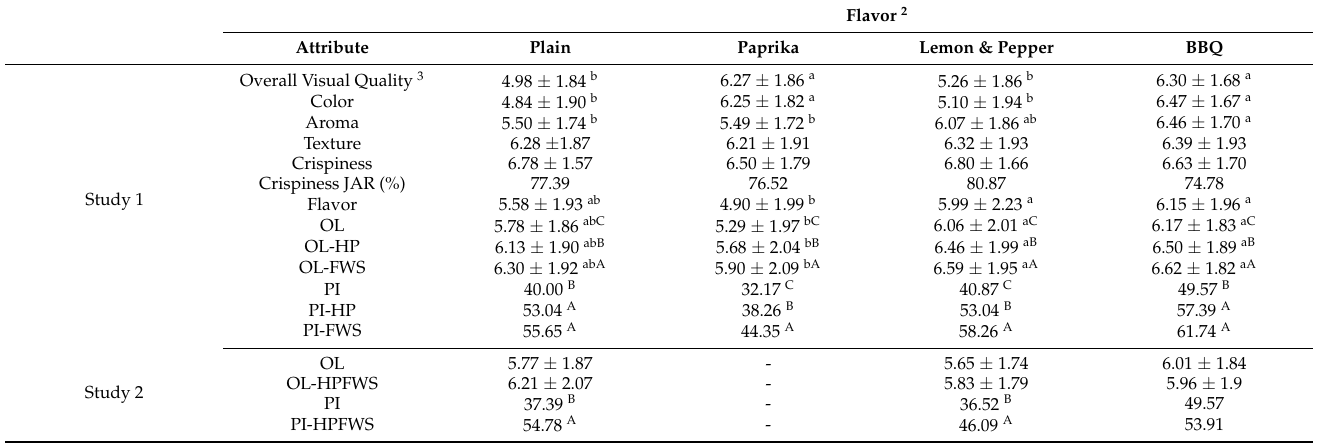
Table 2. Consumer perceptions of catfish skin from two studies 1 .